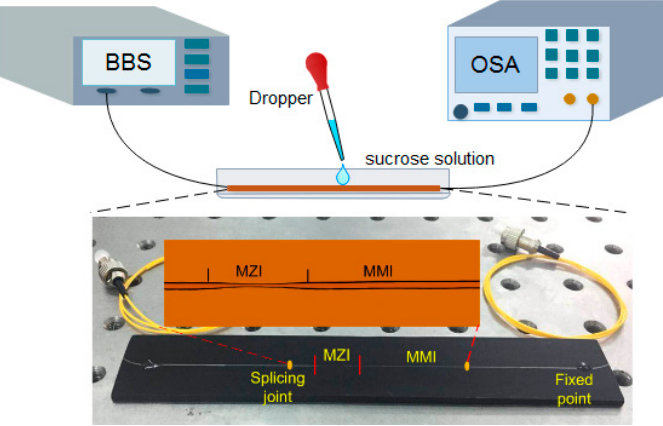
Figure 4. Experimental setup for RI measurement.